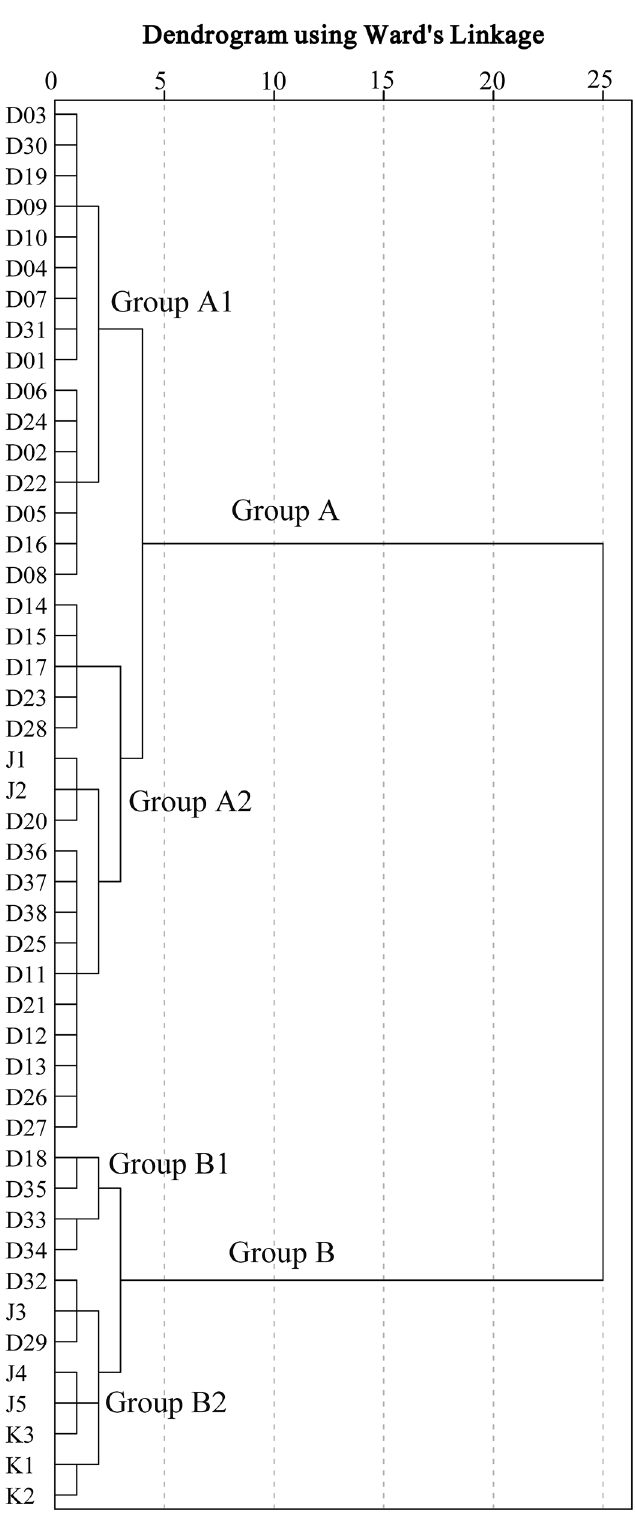
Figure 5. Dendrogram of Q-mode